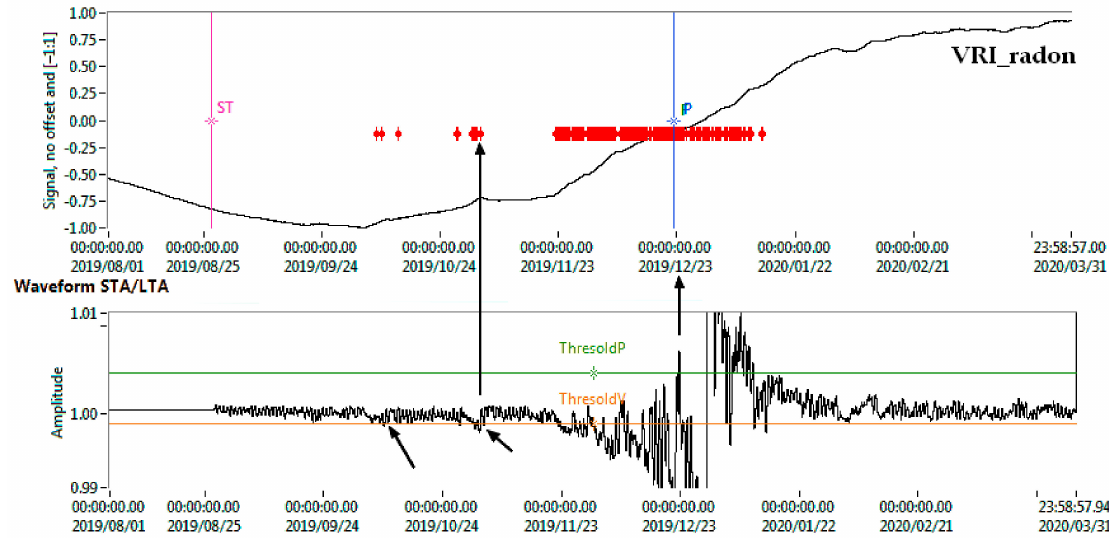
Figure 2. Anomaly detection using short-time-average through long-time-average (STA/LTA) triggering